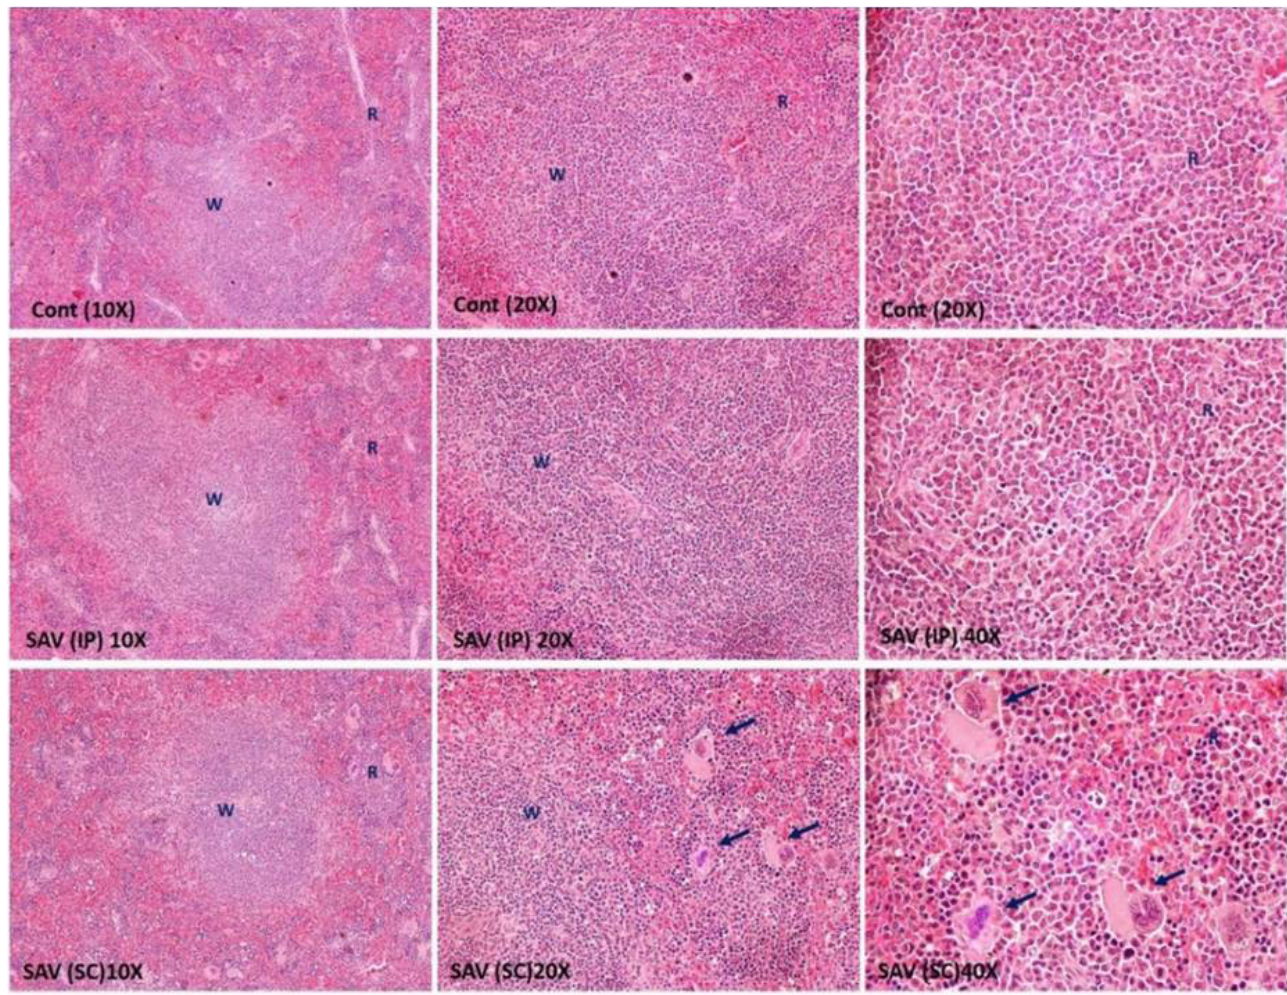
Figure 7. Representative photomicrographs of spleen tissue showing white (W) and red (R) pulps. Arrows show the megakaryocyte infiltration. Each group has three magnifications (10×, 20×, 40× and HE). Many rat spleens were histologically examined for pathological changes. Cont: control group, SAV: samsum ant venom, IP: intraperitoneal, SC: